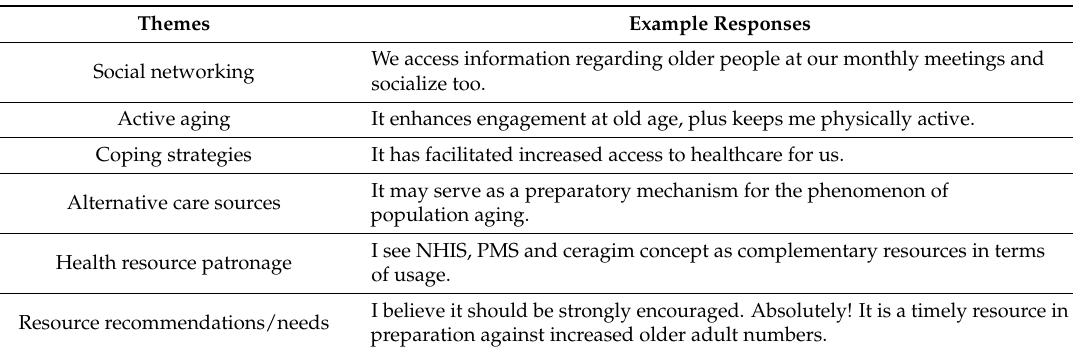
Table 3. Primary themes and examples of